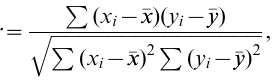
Figure S2 Variation in the wc-1 LOV/PAS/PAS region.